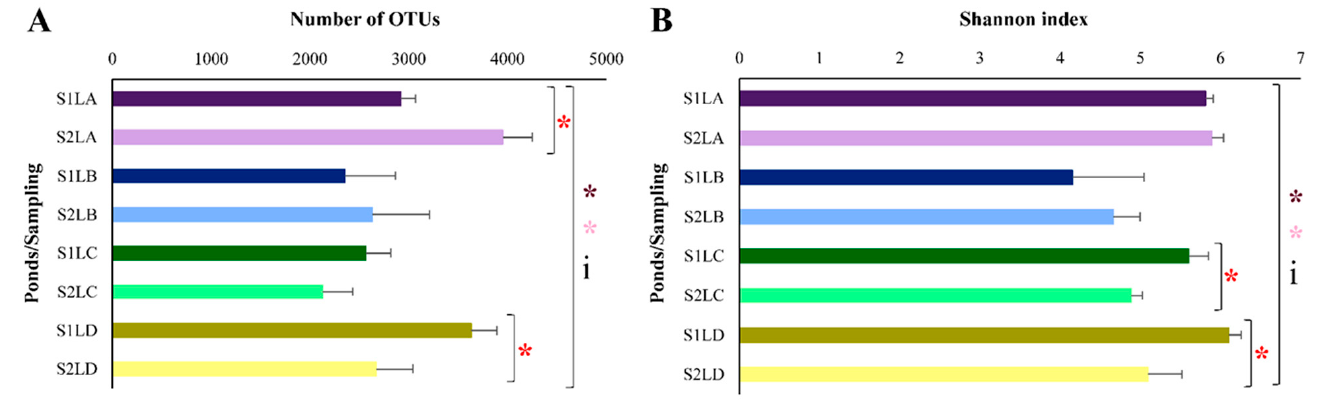
Figure 2. Alpha diversity evaluated by massive sequencing of the gene encoding 16S rRNA in water samples collected in LA (purple), LB (blue), LC (green) and LD (yellow) in S1 (high rainfall period—dark tones) and in S2 (low rainfall period—light tones). The bars represent the standard deviation. Species richness and alpha diversity showed significant differences between the ponds in the two samplings (parametric data submitted to a one-way ANOVA) represented by asterisks (dark pink for S1 and light pink for S2). A red asterisk represents the significant difference among the ponds at each sampling (parametric data submitted to the t test). The data were also submitted to a two-way ANOVA, and the interaction between the factors is represented by the letter i. ( A ) Richness evaluated by the number of OTUs; ( B ) Shannon diversity index.